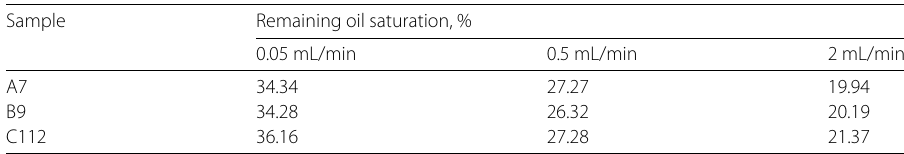
Figure 7 T2 distribution curve of sample A7 in different flow speed